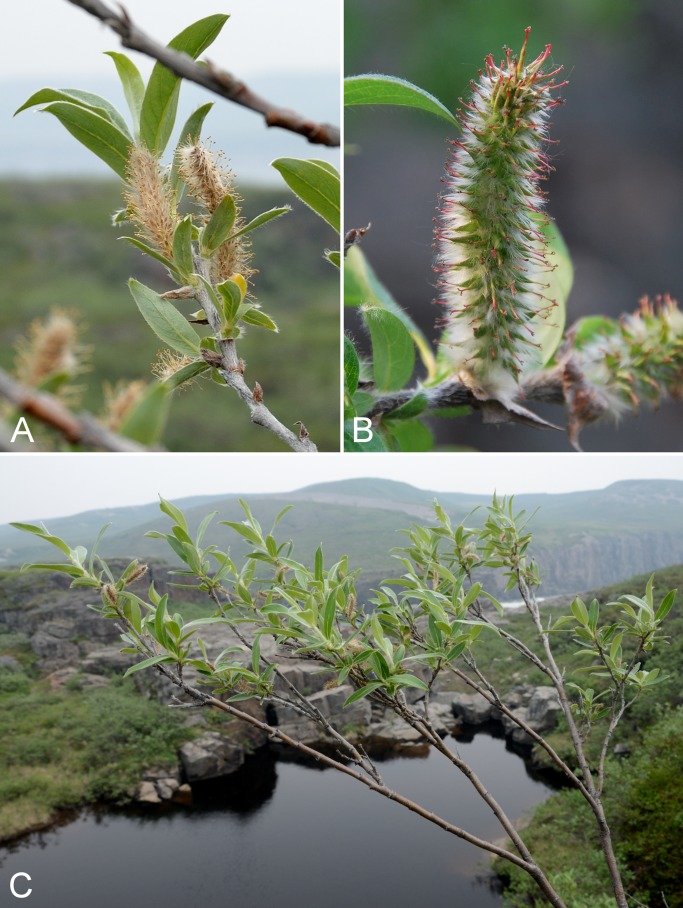
Salix richardsonii.(A) Staminate catkins, Saarela et al. 3885. (B) Pistillate catkin, Saarela et al. 3885. (C) Habit, Saarela et al. 3885. Photographs by R. D. Bull (A, C) and J. M. Saarela (B).